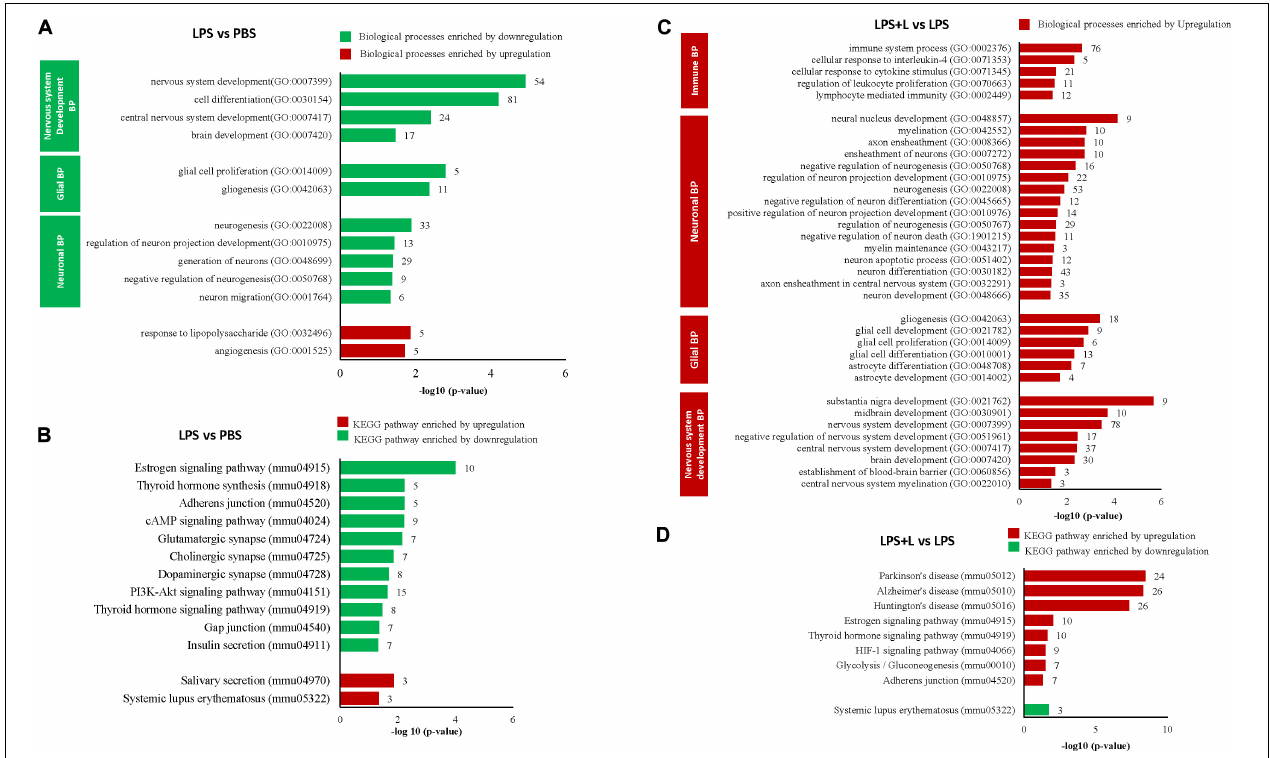
FIGURE 4 | Luteolin treatment significantly regulated gene expression in NSCs of LPS-induced depression mice model. (A,B) Differentially regulated biological processes (BP) and top significantly enriched KEGG signaling pathways in NSCs of LPS-induced depression mice (LPS) compared to untreated mice (PBS). (C,D) Differentially regulated biological processes (BP) and top significantly enriched KEGG signaling pathways in NSCs of LPS-induced depression mice treated with luteolin (LPS + L) compared to untreated LPS-induced depression mice